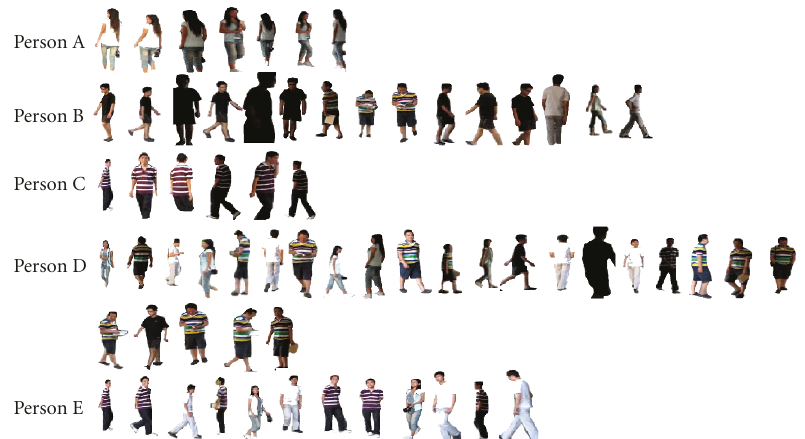
Figure 18: Trajectories recovered by EM with forward appr.I inference initialized by K-means